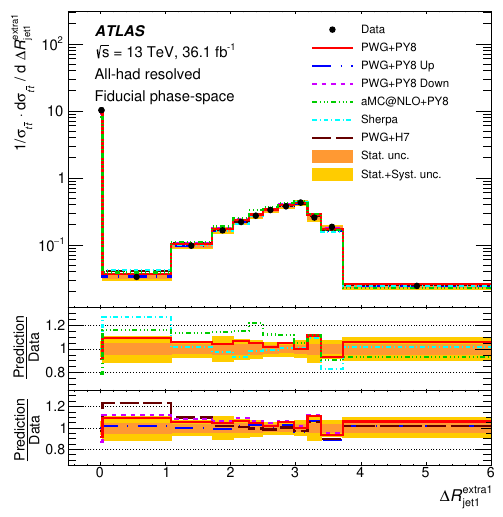
Figure 14 . Particle-level normalised single-differential cross-section as a function of the angular separation ∆ R between the leading extra jet and leading jet. In the top panel, the unfolded data are shown as black points, while lines indicate the predictions from several MC programs. Uncertainties are shown by the shaded bands. Data points are placed at the centre of each bin. The lower two panels show the ratio of the MC predictions to the unfolded